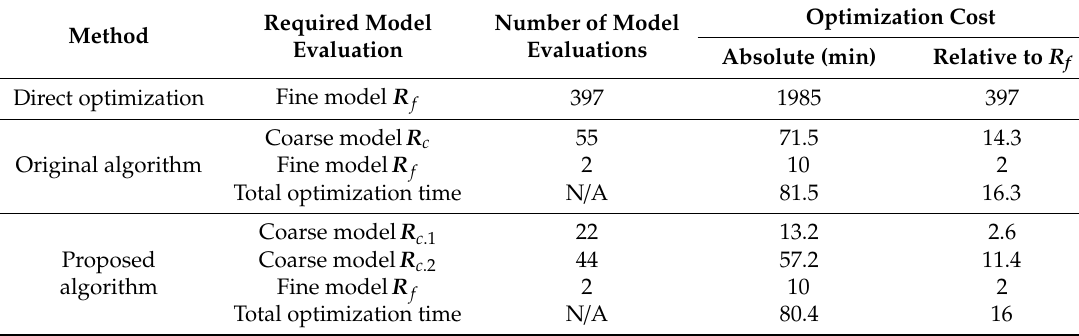
Table 1. Second-order ring resonator bandpass microstrip filter: optimization cost.